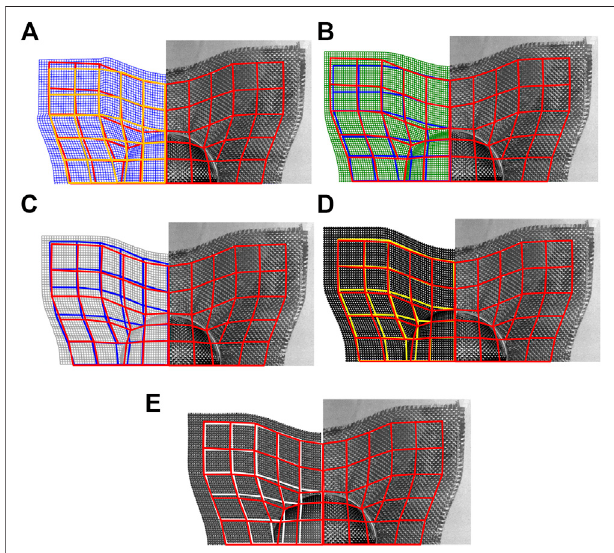
FIGURE 6 | Comparison of the predicted formed fabric pro fi les with experiment resutls in (A) the kinematic draping model (pro fi le marked with yellow lines), (B) the FEA-PJN model (pro fi le marked with blue lines), (C) the HypoDrape model (pro fi le marked with blue lines), (D) the MF model (isolated yarns coloured in yellow), and (E) the 3DShell model (isolated yarns coloured in white) for hemispheric forming. Deformed pro fi le of the specimen (only quarter of which is shown) indicated by red lines at the RHS isoverlaid to the deformed pro fi le of fabric model shown at the